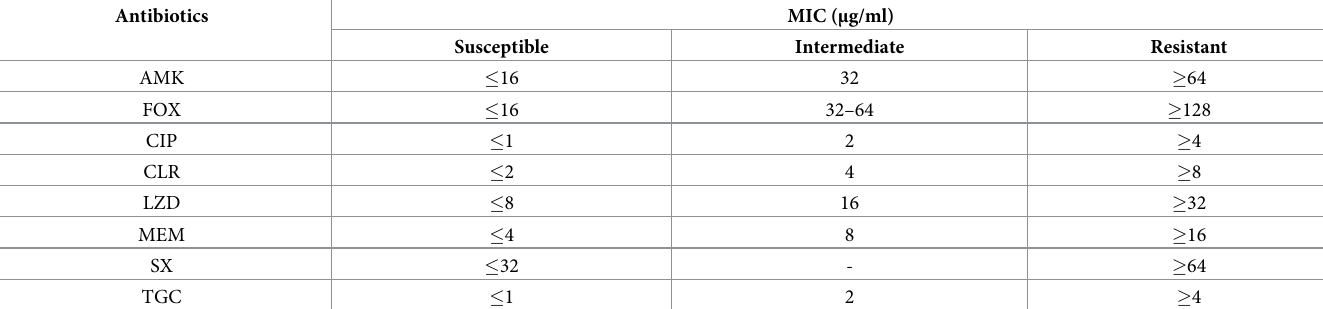
Table 1. Antibiotic breakpoints used for interpretation of RGM susceptibility.